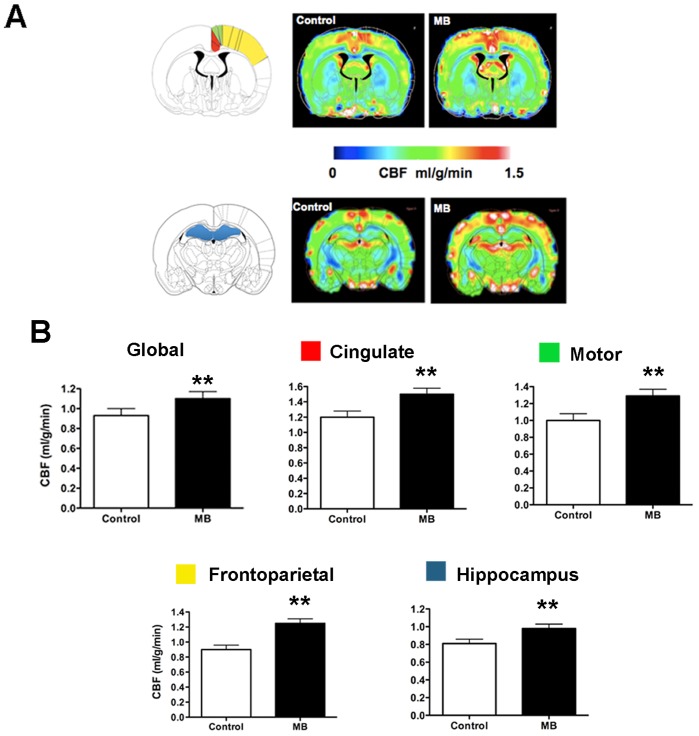
MB enhances global and regional CBF under normoxic
conditions. (A) Brain regions related to PD and AD pathology and the CBF maps under control (normoxia) and MB (normoxia + MB) conditions. Red, cingulate cortex; green, motor cortex; yellow, frontoparietal cortex; blue, hippocampus. (B) Global CBF and regional CBF in cingulate, motor, frontoparietal cortices and hippocampus. Data are mean ± SD; **, p<0.01.